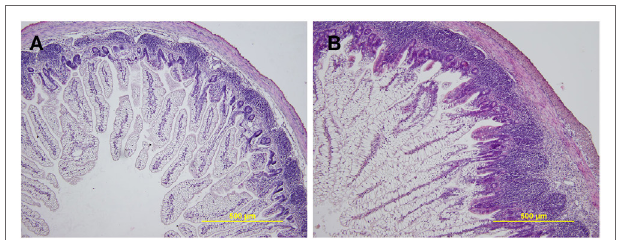
FigUre 1 | Representative hematoxylin and eosin-stained cross sections of the ileum in the preterm germ-free and term germ-free piglets. The villi in the ileum of the preterm piglets (a) are shorter, the Peyer’s Patches are smaller, and the cellularity of the lamina propria mucosa and submucosa is lower in comparison with their term counterparts (B) . A total of five piglets per group were analyzed. Magnification: ×